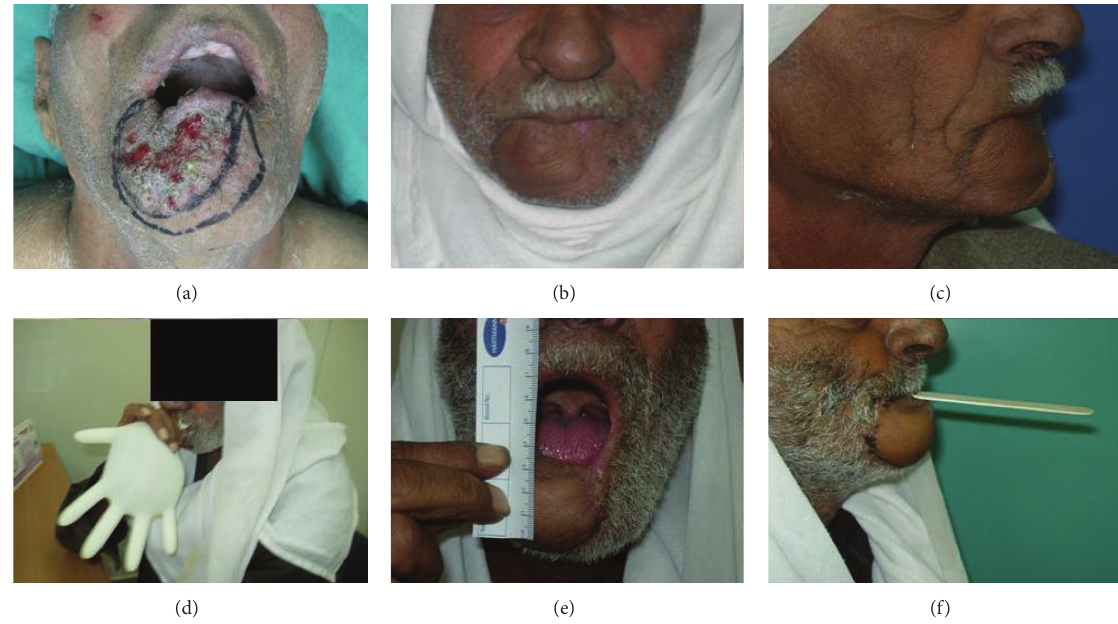
Figure 5: Patient number 5: (a) preoperative tumor resection outlined, (b) Postoperative anterior view, and (c) lateral view. Lip function: (d) patient is blowing a rubber glove. (e) Mouth wide open. (f) Patient is holding a wooden mouth opener with his lips only showing good lip